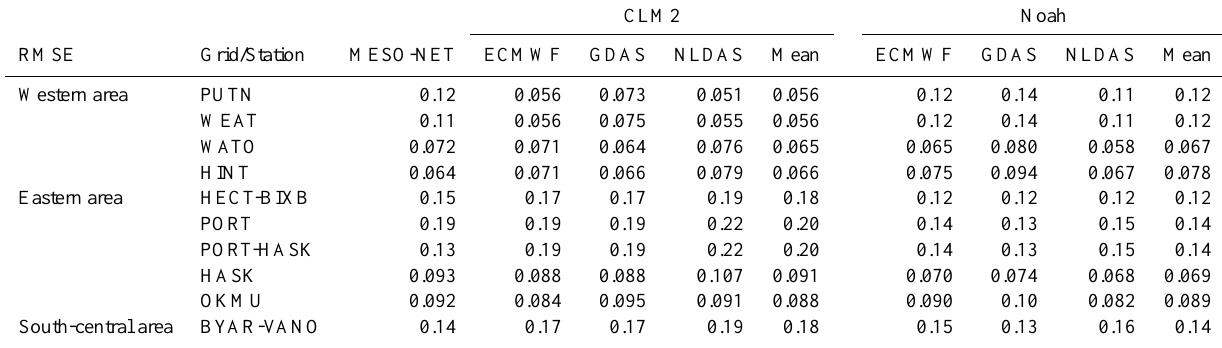
Table 1. RMSE (m 3 m − 3 ) of the current VUA relative soil moisture product vs. ground-observed and modelled soil moisture estimates. CLM2 Noah